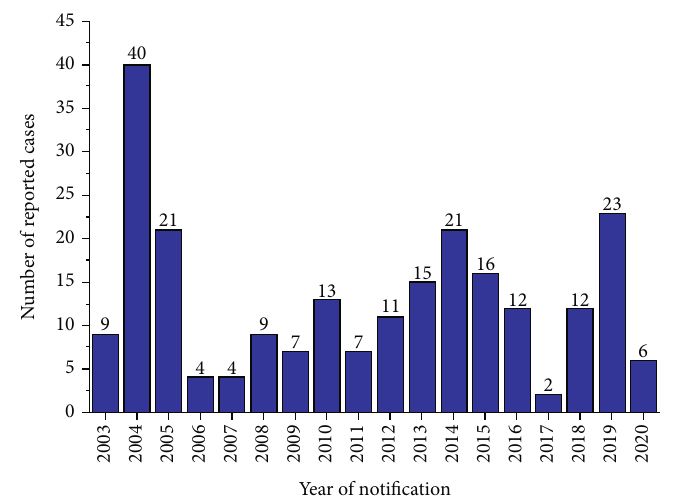
Figure 2: Number of noti fi cation reports per year for chilli pepper adulteration/fraud within the period 2003 to